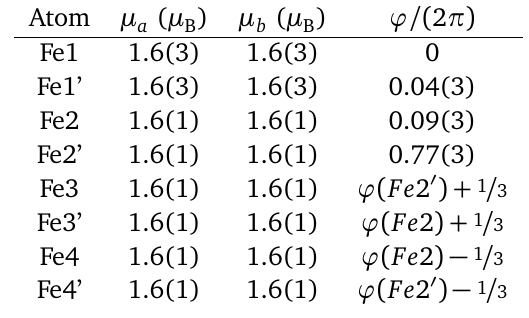
Table 5: Refined magnetic parameters of the modulated in-plane magnetic structure = 12.7). The numbering of Fe atoms is analogous to Table 1 component at 15 K ( R F and the positions of the primed Fe atoms are related to the unprimed ones by the b glide plane lost in the